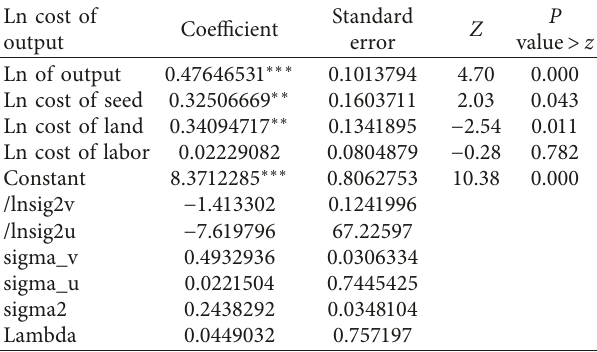
Table 2: Estimation of cost